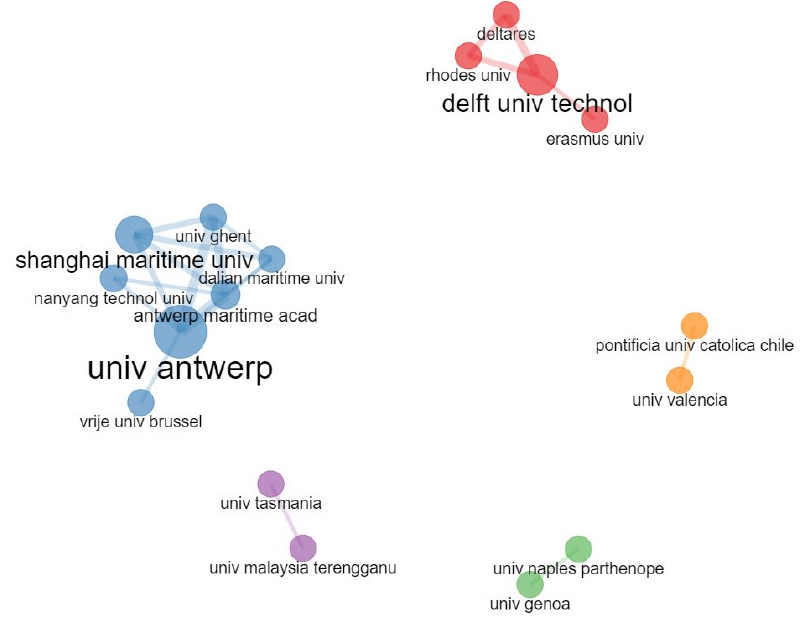
Figure 3. The most prestigious academic institutions’ collaboration network strength.